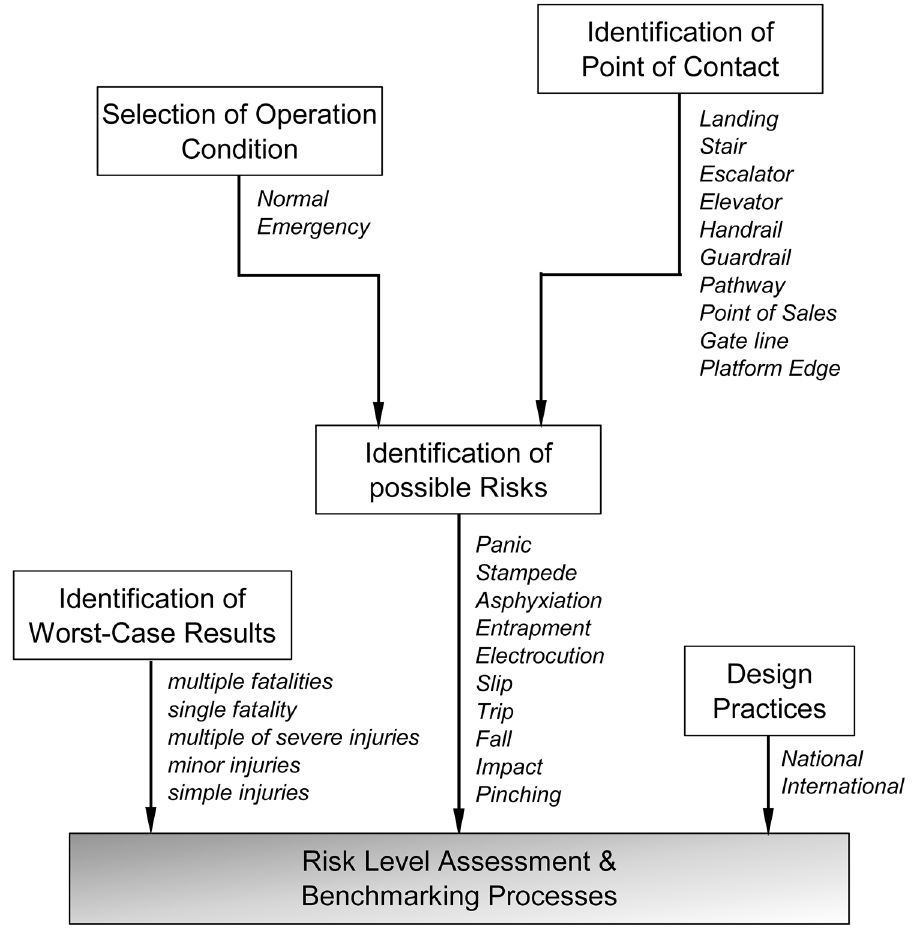
Fig. 3 Risk assessment and benchmarking methodology for passenger hazard exposure in open mass transit